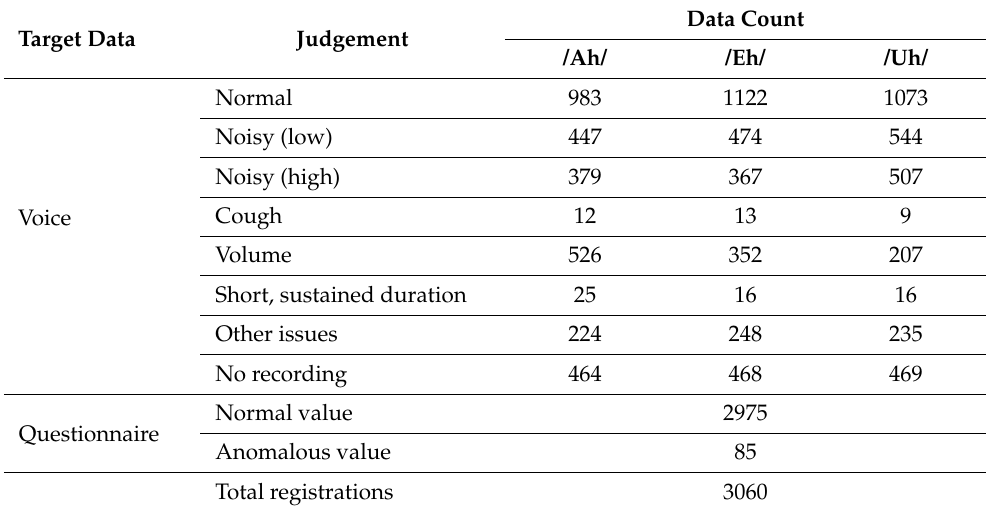
Table 13. Judgement results of subjective evaluation of all voice data and questionnaire